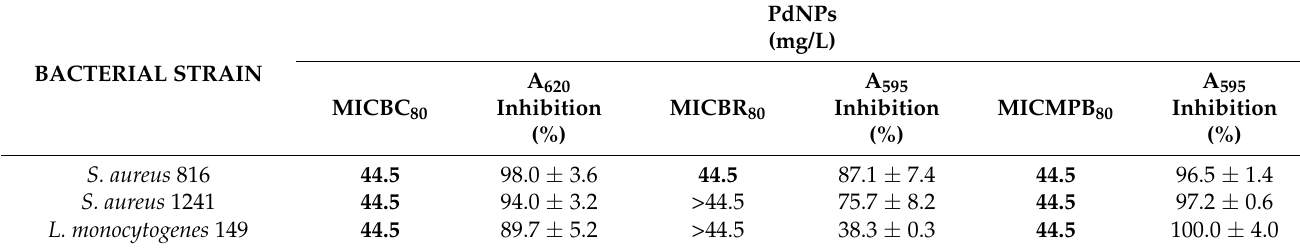
Table 3. Minimal concentrations inhibiting further growth of biofilm cells, biofilm reduction and biofilm metabolic activity with their respective inhibitory rates of PdNPs for biofilms. Data represent the mean of at least three independent replicates. The significance of the results was verified by t -test ( p ≤